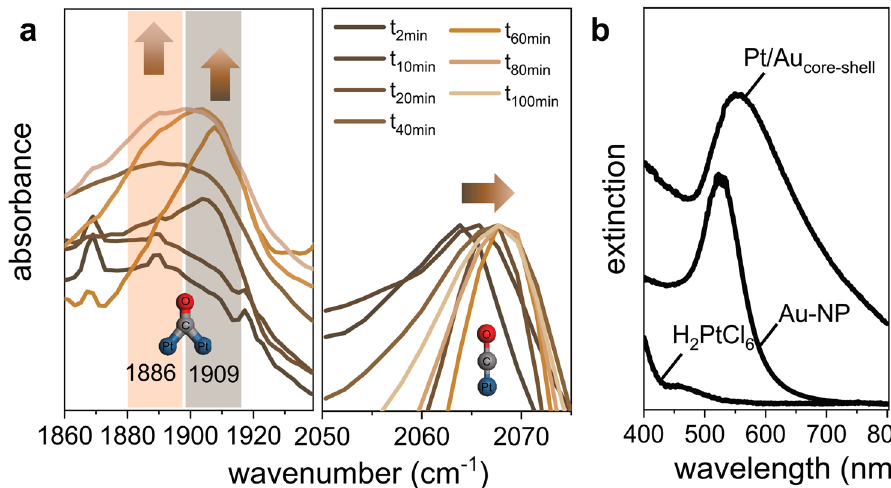
Fig. 3 Growth of core-shell Pt/Au nanoparticles. a ATR-FTIR analysis of aliquots after different time intervals while the reduction of Pt was quenched in the presence of dissolved CO. b UV-Vis spectra of 5 mM H 2 PtCl 6 , citrate-stabilized Au-nanoparticles and Pt/Au core-shell nanoparticles directly after synthesis.